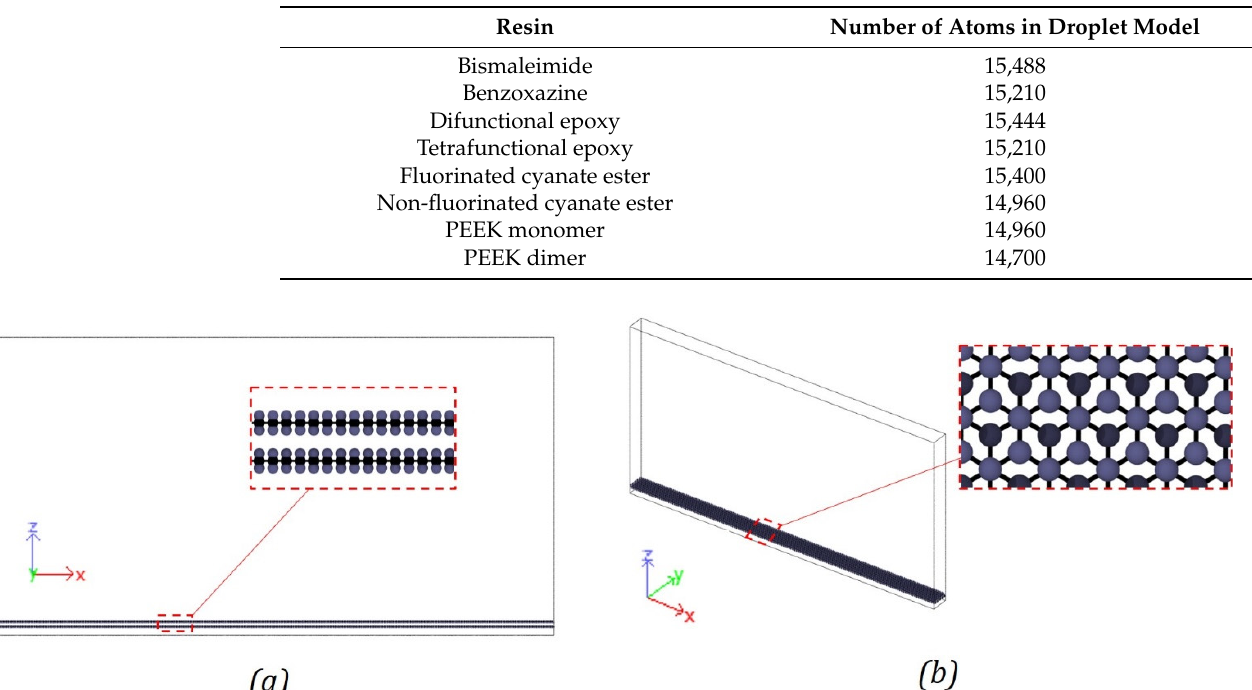
Table 1. Number of atoms in droplet models.